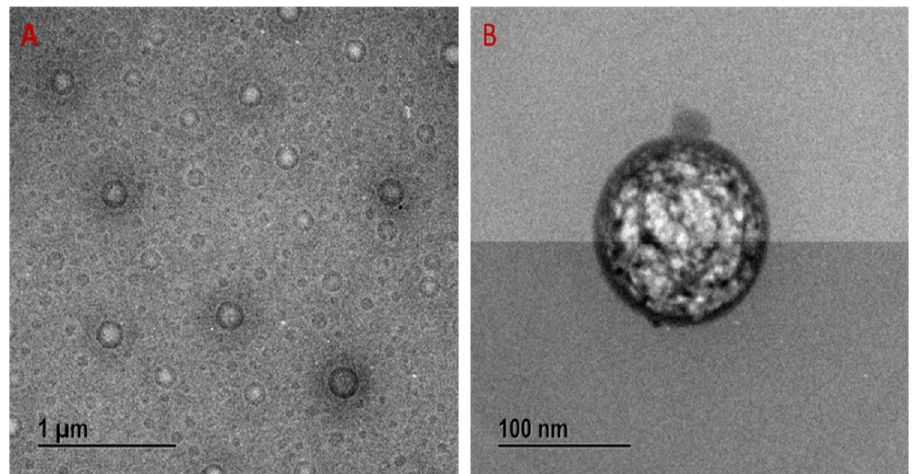
Figure 3. FE-TEM images of Panos nanoemulsion, ( A ) 1 µm scale bar; ( B ) 100 nm.